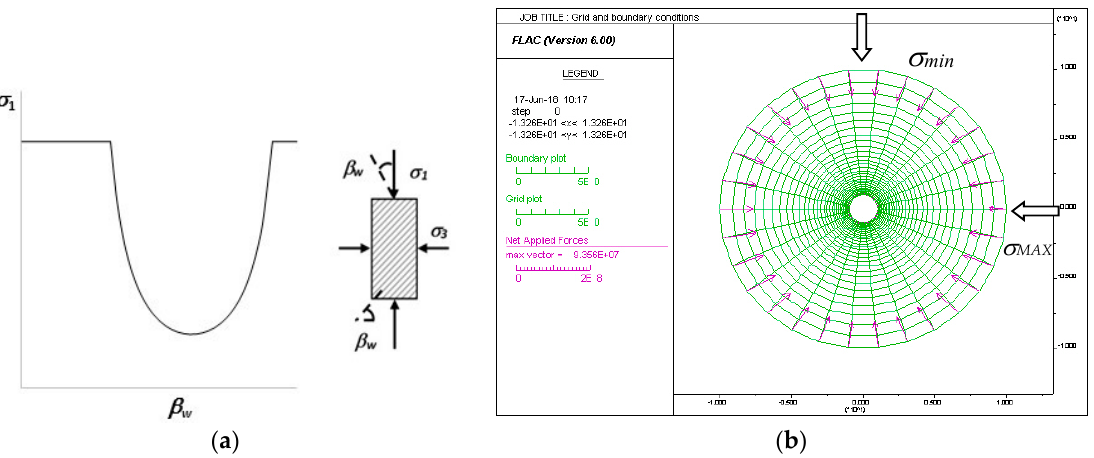
Figure 2. ( a ) Rock specimen containing weakness planes with an inclination β w and variation of the strength with β w (Equation (2)). ( b ) Grid and boundary conditions adopted in the Fast Lagrangian Analysis of Continua (FLAC) simulations. σ x = σ MAX (horizontal), σ y = σ min (vertical) and σ II is the out of plane stress.